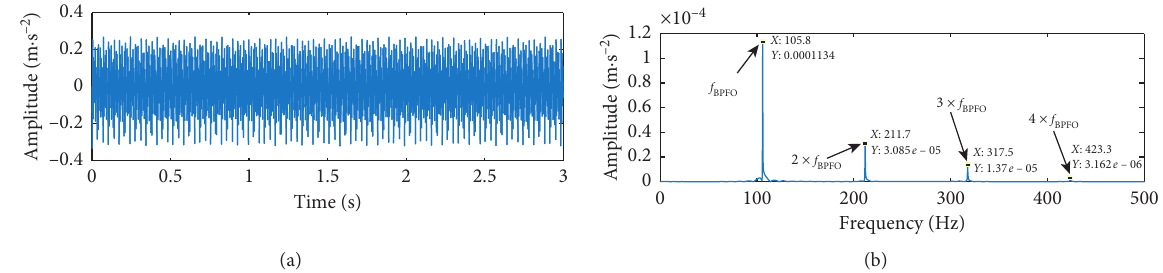
Figure 14: Simulated signal for a localized fault being 0.007 inches under 1772rpm. (a) Simulated signal in time domain. (b) Simulated signal in frequency domain.